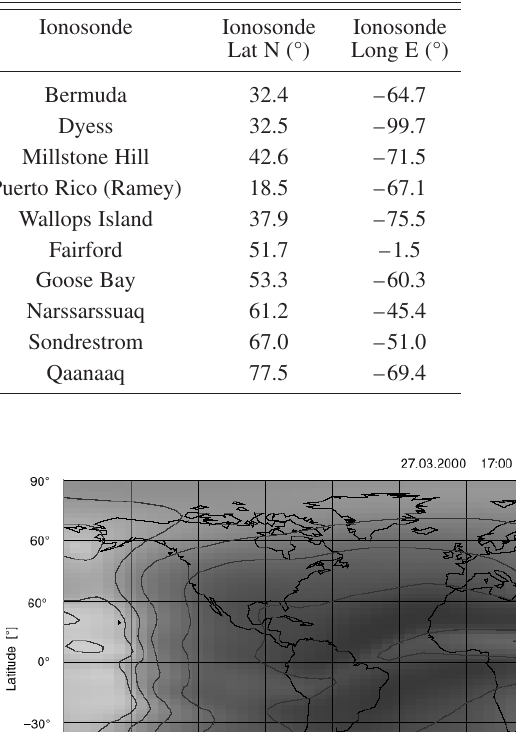
Table II. Ionosondes used to validate the electron density reconstruction technique based on NeQuick model driven by Az grids derived from La Plata ver- tical TEC maps for the day 27 March